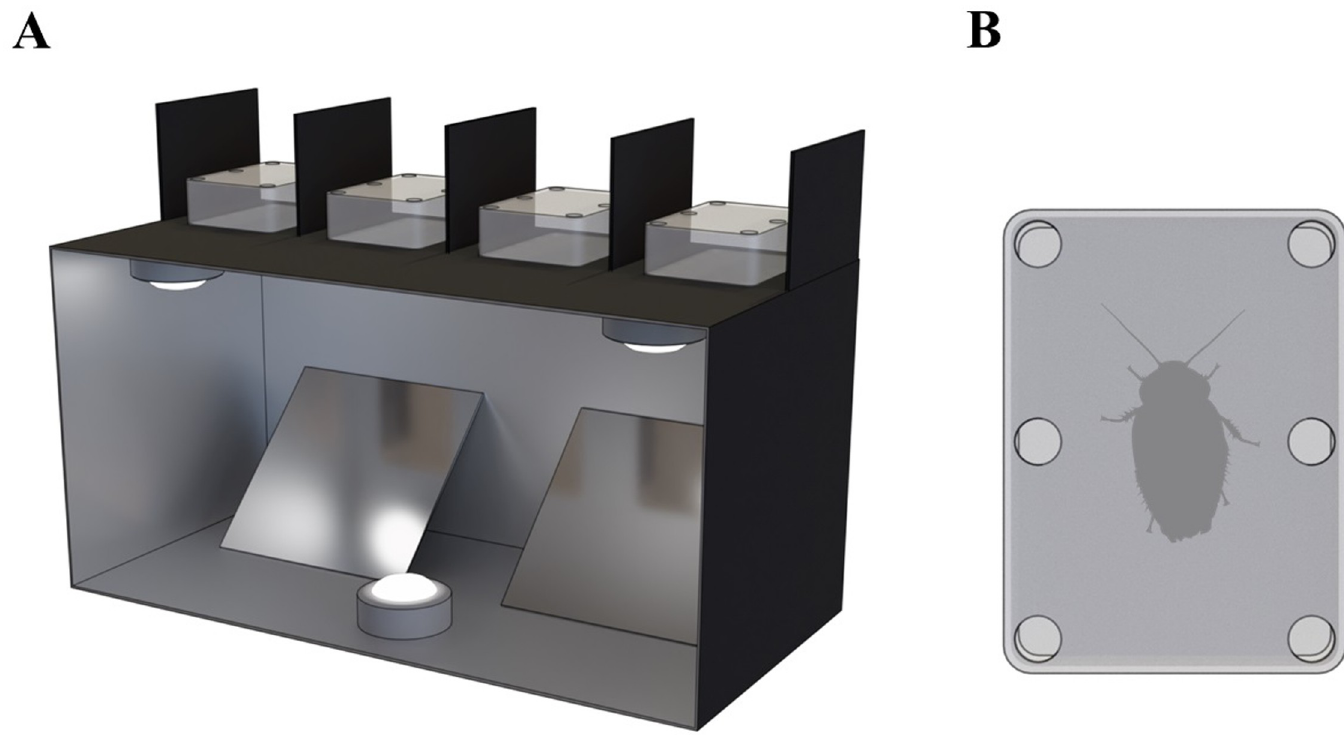
Fig 1. Apparatus diagram. (A) Filming unit containing four clear plastic experiment chambers. Three internal lights were used to supplement room lighting. Mirrors were used to film the ventral side of subjects. (B) Top view of one experiment chamber. Six holes in the top of the chambers permitted stimulus